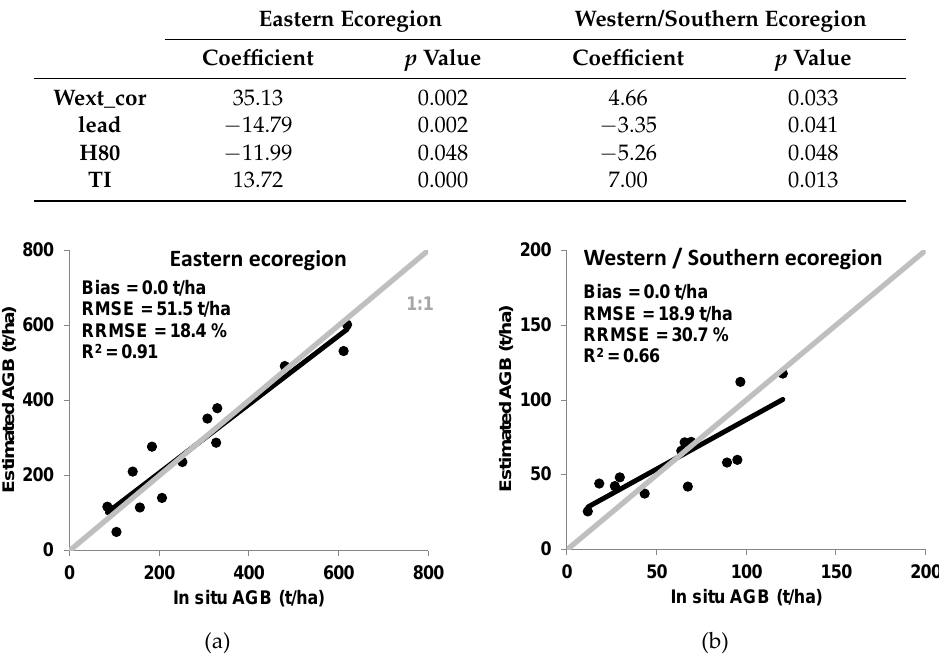
Figure 4. AGB estimation from significant GLAS and Digital Elevation Model (DEM) metrics as a function of in situ AGB in the eastern ( a ) and western and southern ecoregions ( b ).